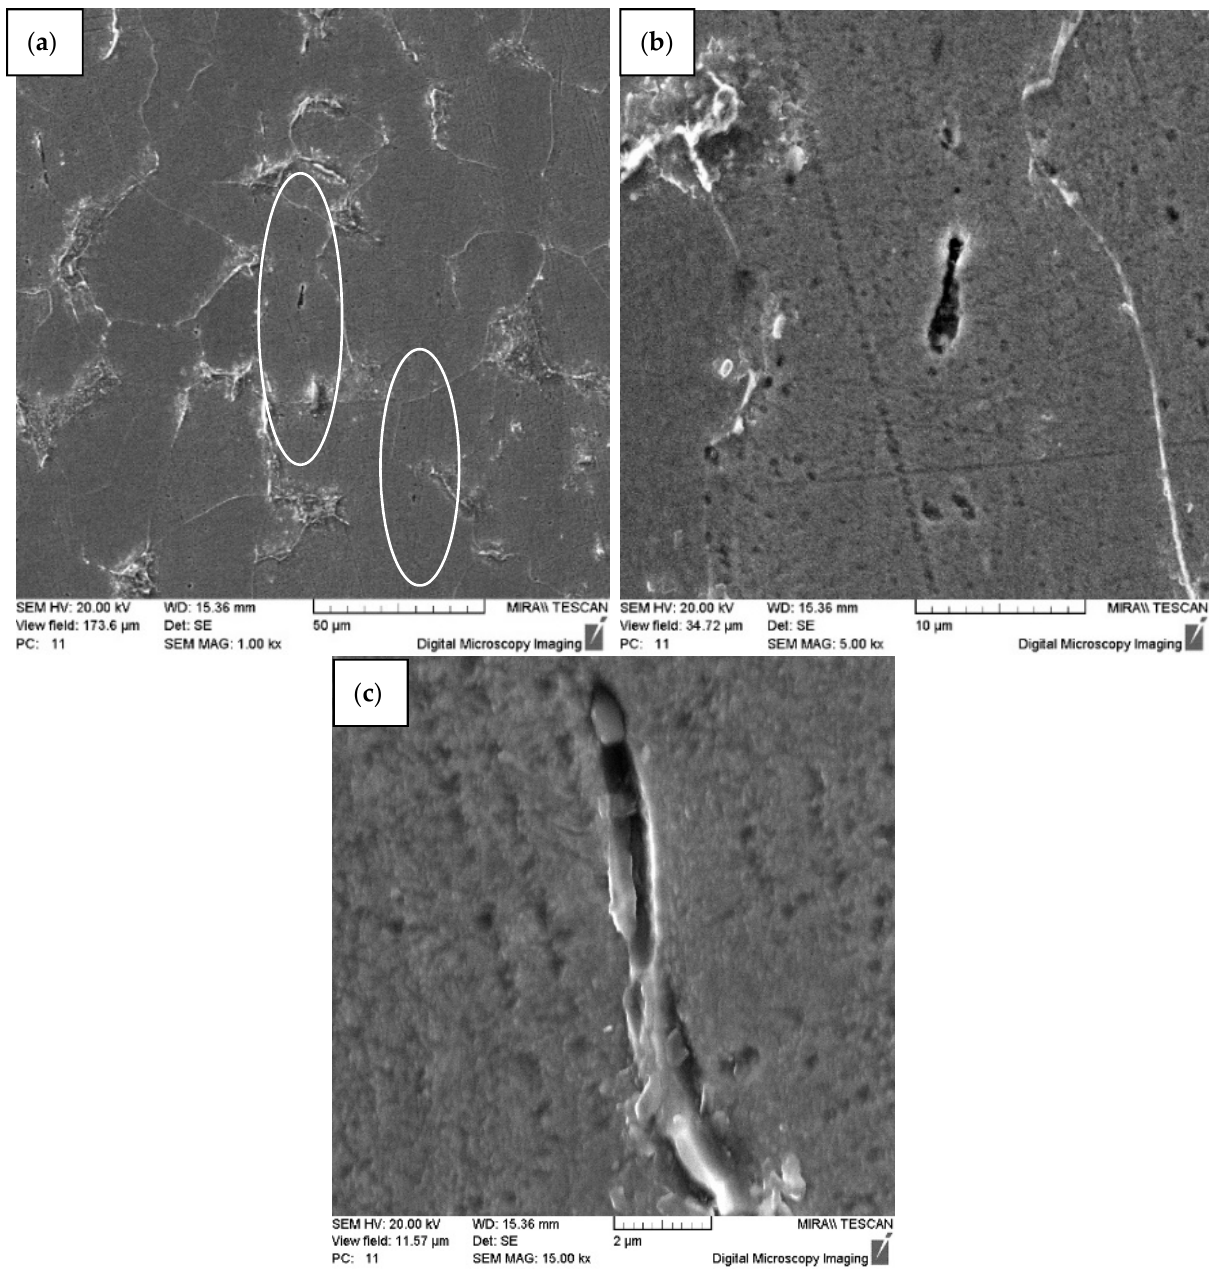
Figure 3. The structure of steel St3 after the dynamic alloying in the SDP mode. Longitudinal direction of the section (along the direction of particle stream): ( a ) Microstructure of steel St3 after the dynamic alloying in the SDP mode with channels (in circles); ( b , c ) channel element (fiber). Table 3. Analysis of the composition of the channel element site in steel 10 after dynamic alloying in the SDP